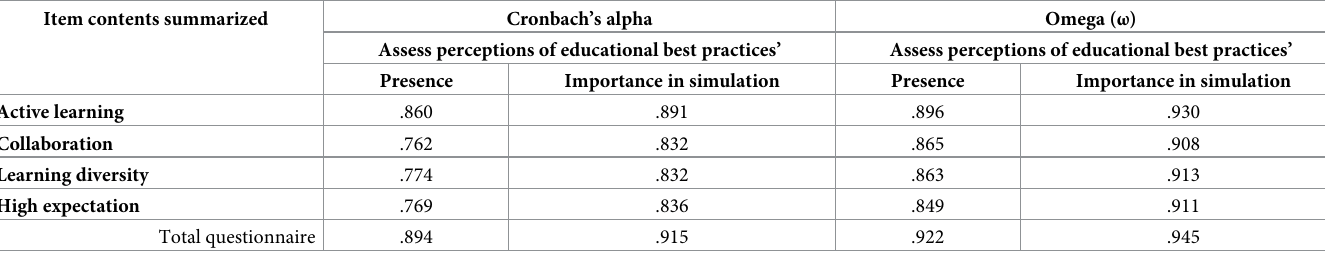
Table 7. Internal consistency coefficient (Cronbach’s alpha and Omega) for the Educational Practices Questionnaire